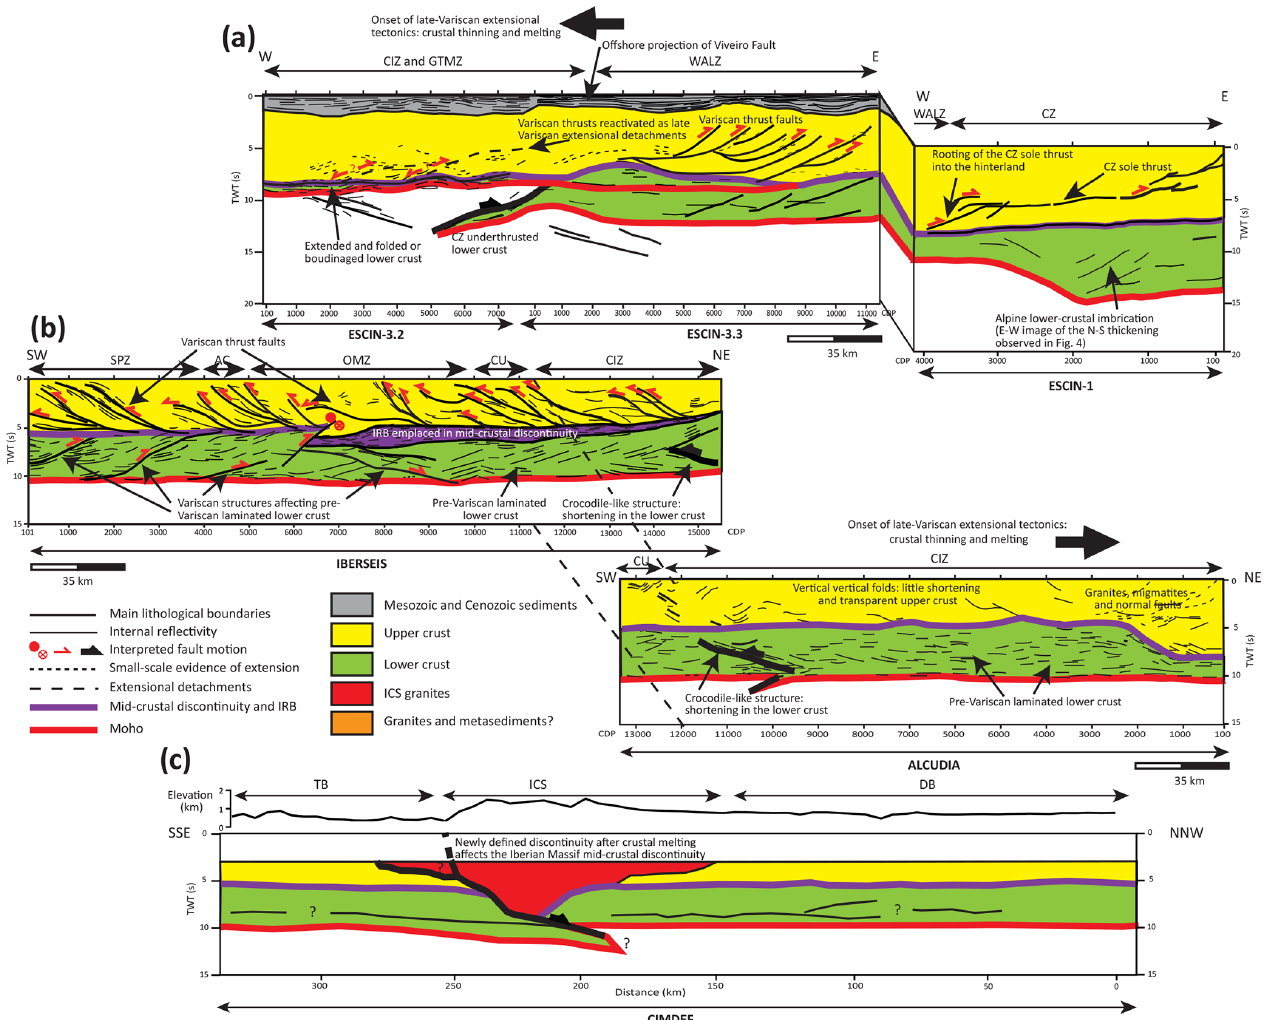
Figure 9. Joint geological interpretation of all of the seismic sections (normal incidence and seismic noise) whose location is shown in Fig. 1: (a) ESCIN-1, ESCIN3-3, and ESCIN-3.2; (b) ALCUDIA and IBERSEIS; and (c) CIMDEF (Andrés et al., 2020). Special attention should be paid to the depth and geometry of the Moho and mid-crustal discontinuity. Alpine structures (i.e., crustal thickening) appear in ESCIN-1 and in CIMDEF. The rest are Variscan